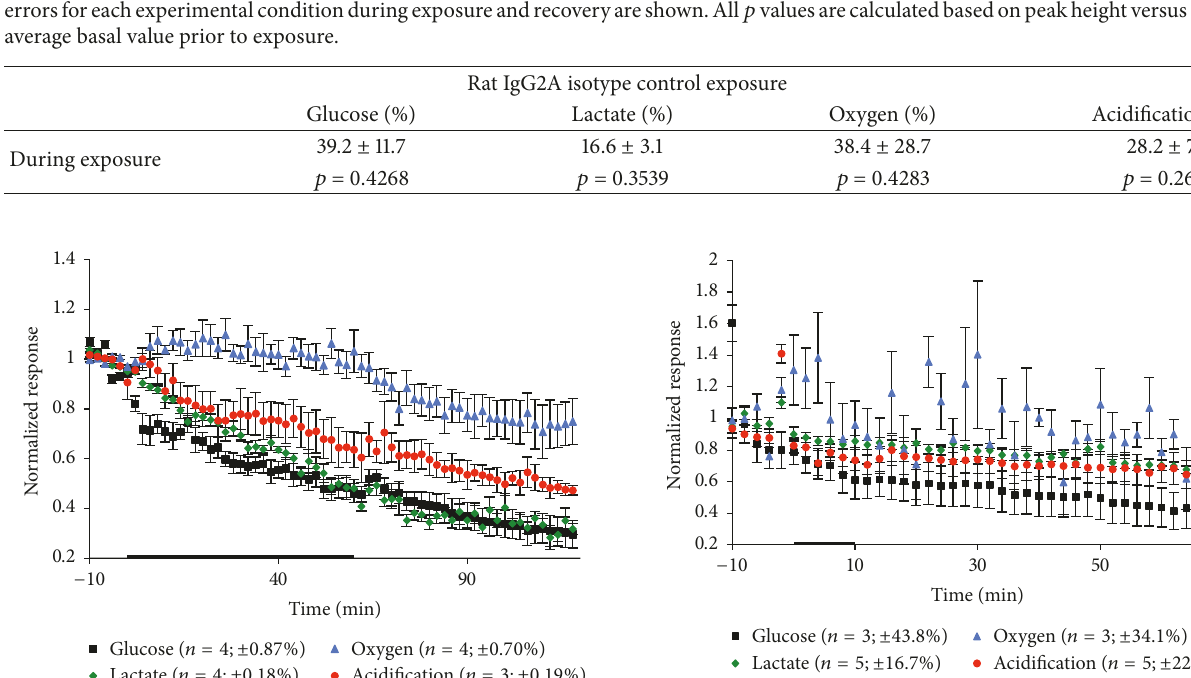
Figure 7: Average metabolic response of RAW 264.7 cells to a 60 min exposure of 50 mg/mL trehalose. The black bar indicates the exposure time. The number of experiments and standard error of the mean for the basal metabolic rate 10 min before exposure to the antibody are given in parentheses.